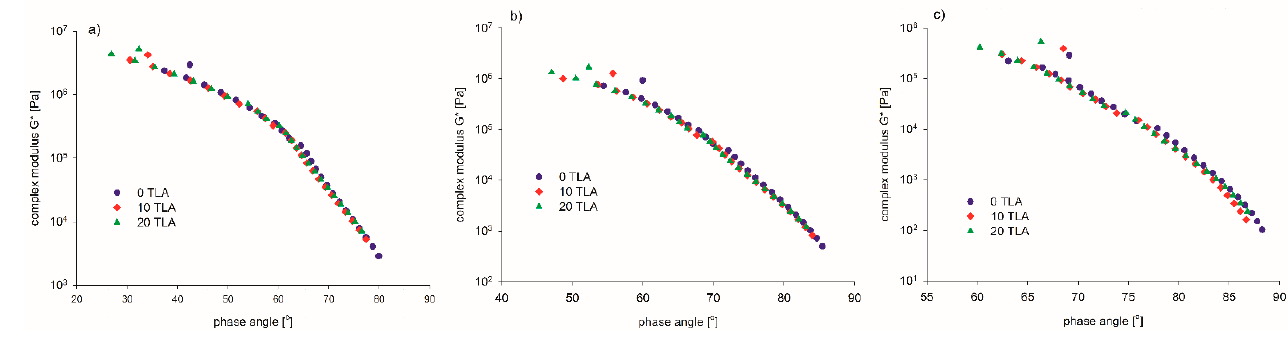
Figure 8. Black curves of TLA-modified binders at ( a ) 40 °C; ( b ) 50 °C; ( c ) 60 °C.